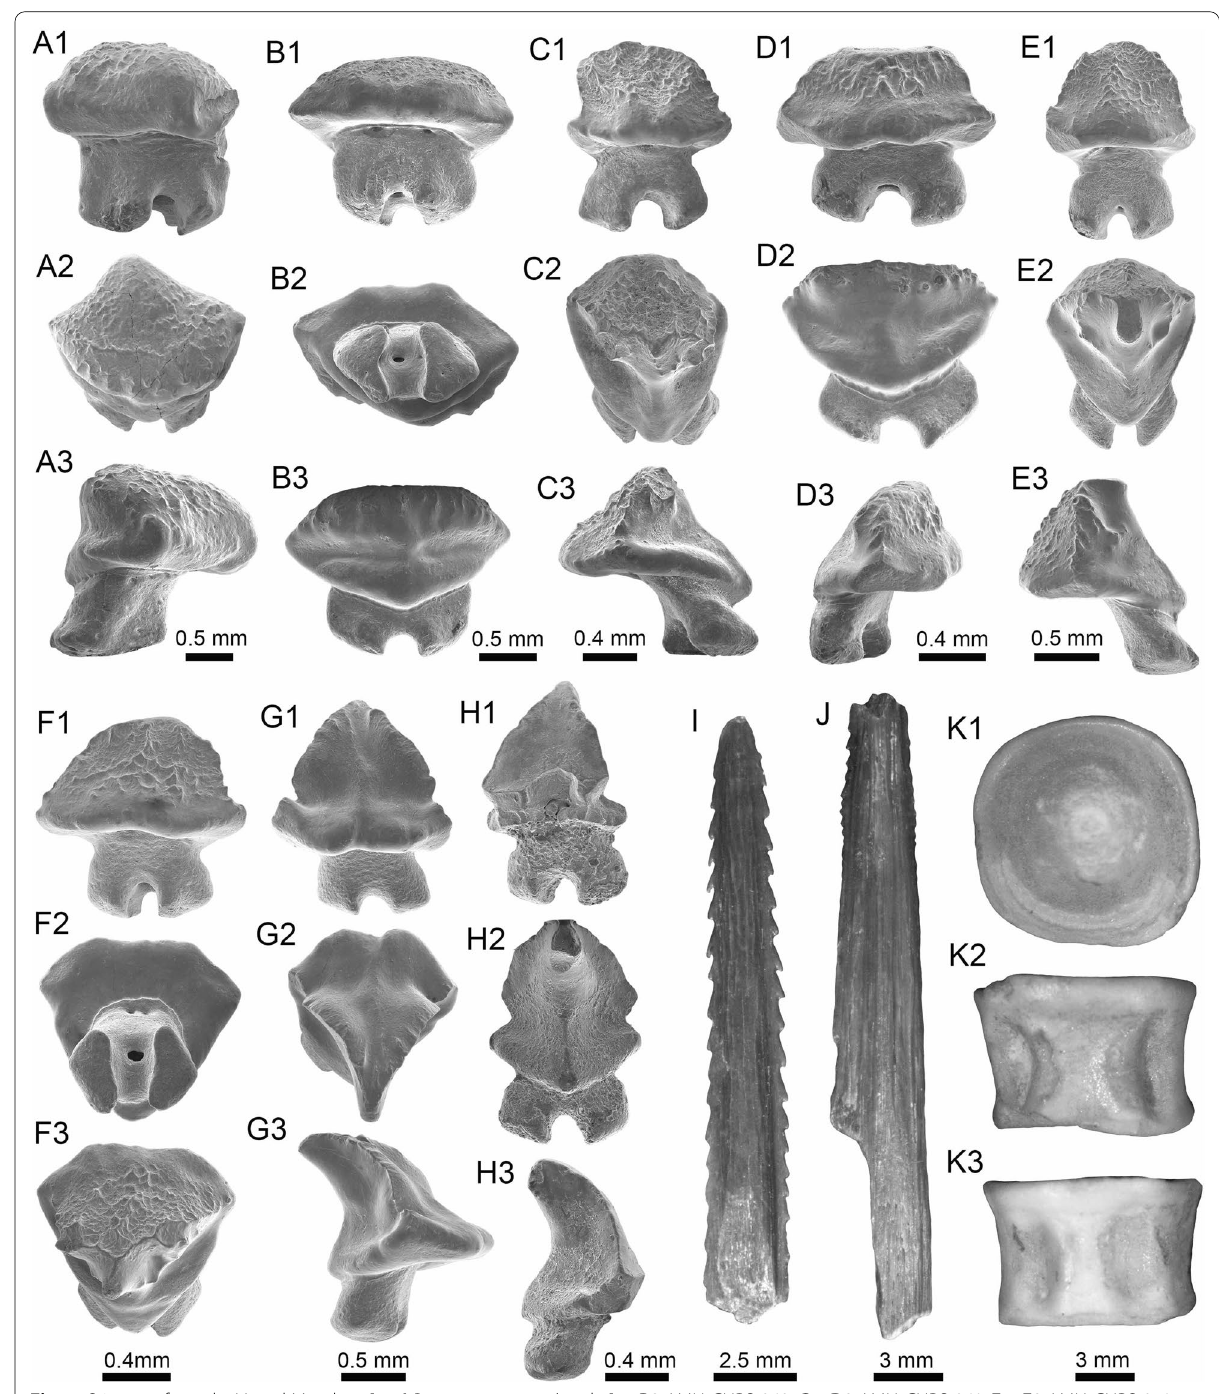
Fig. 4 Stingrays from the Vergel Member. A1 – J Potamotrygon sp. (teeth A1 – B3 AMU‑CURS‑868; C1 – D3 AMU‑CURS‑869; E1 – F3 AMU‑CURS‑870; G1 – H3 AMU‑CURS‑871; and caudal spines I , J AMU‑CURS‑865). K1 – K3 Myliobatiformes indet. Views: labial ( A1 , B1 , C1 , D1 , E1 , F1 , G1 , H1 ), lingual ( B3 , D2 , H2 ), occlusal ( A2 , C2 , E2 , F3 , G2 ), lateral ( A3 , C3 , D3 , E3 , G3 , H3 ), basal ( B2 , F2 ), ventral ( I , J ), and indet. ( K1 – K3